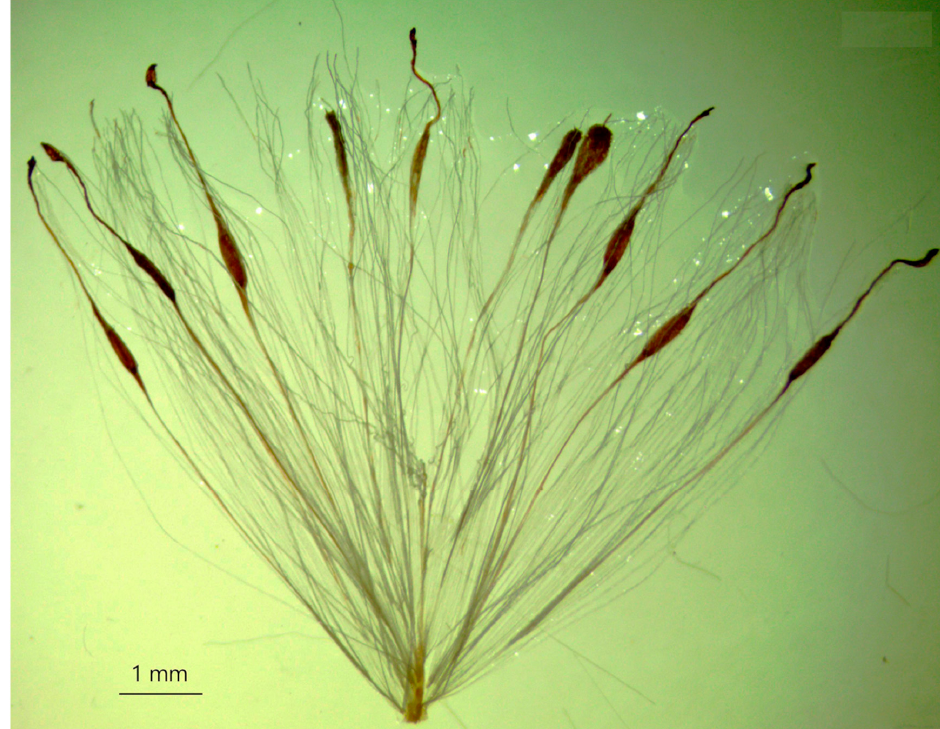
Figure 4. Typha lepechinii sp. nov.: female spikelet. Photo: O. A. Kapitonova.